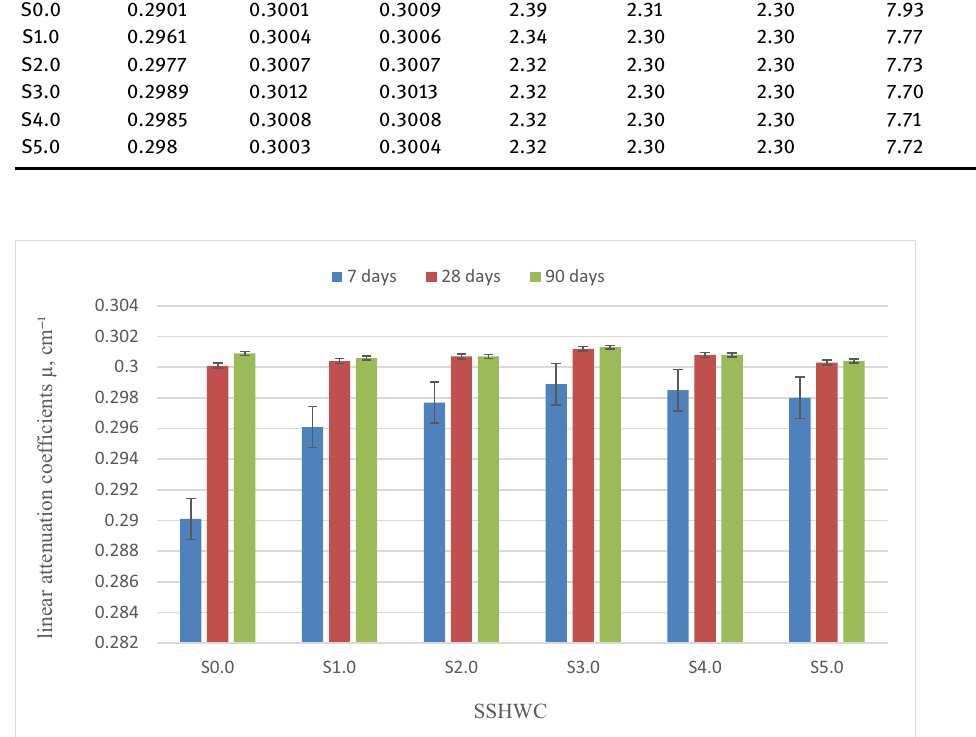
Figure 16: Linear attenuation coe ffi cient ( μ ) of di ff erent SSHWC mixes at di ff erent